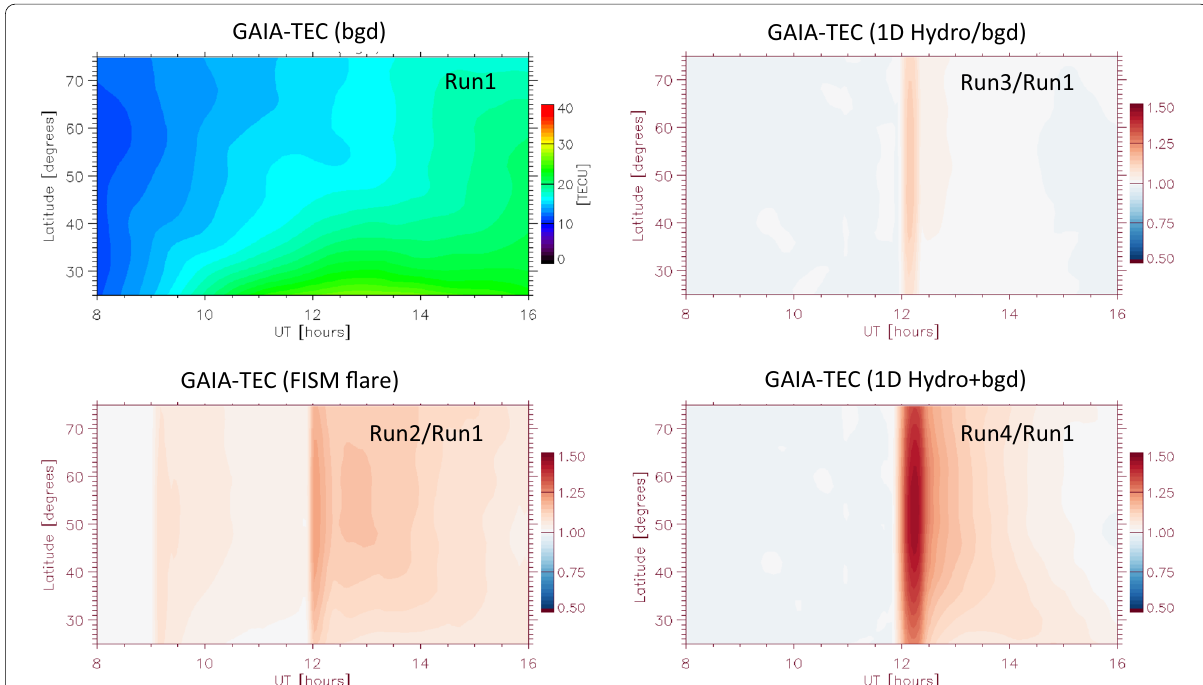
Fig. 8 Ratio of TEC at 0°E 25–75°N calculated by GAIA and the background. Upper left: background TEC distribution. Same as the top-left figure in Fig. 7. Lower left: ratio of TEC for the “FISM” input (Run2/Run1). Upper right: ratio of TEC for the “1D Hydro/bgd” input (Run3/Run1). Lower right: ratio of TEC for the “1D Hydro bgd” input (Run4/Run1) +